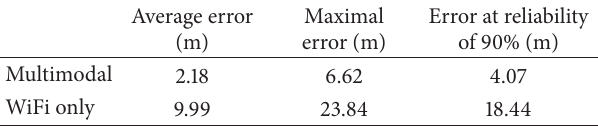
Table 1: Multimodal and WiFi-only localization error comparison.